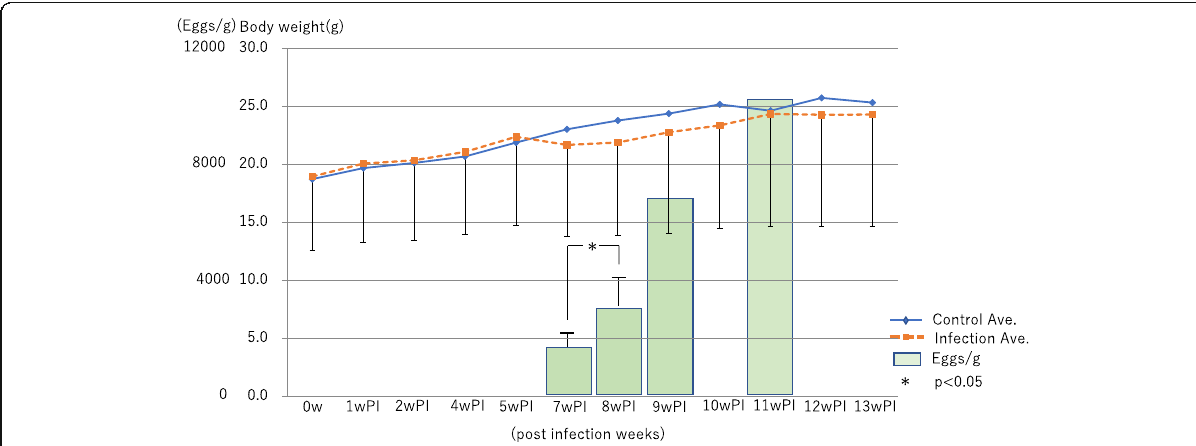
Fig. 1 Observation of body weight and EPG. Dotted line lines indicate changes in body weight of infected mice and solid line lines indicate control mice. The bars showed EPG. Differences in body weight seemed to be apparent between infected mice and control mice after 7 weeks PI. However, there was no significant difference between control and infected